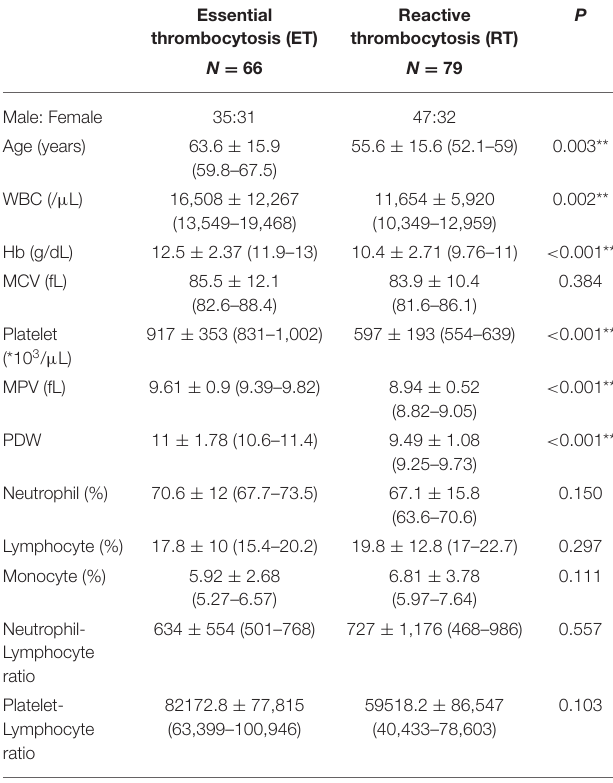
TABLE 1 | Characteristics of